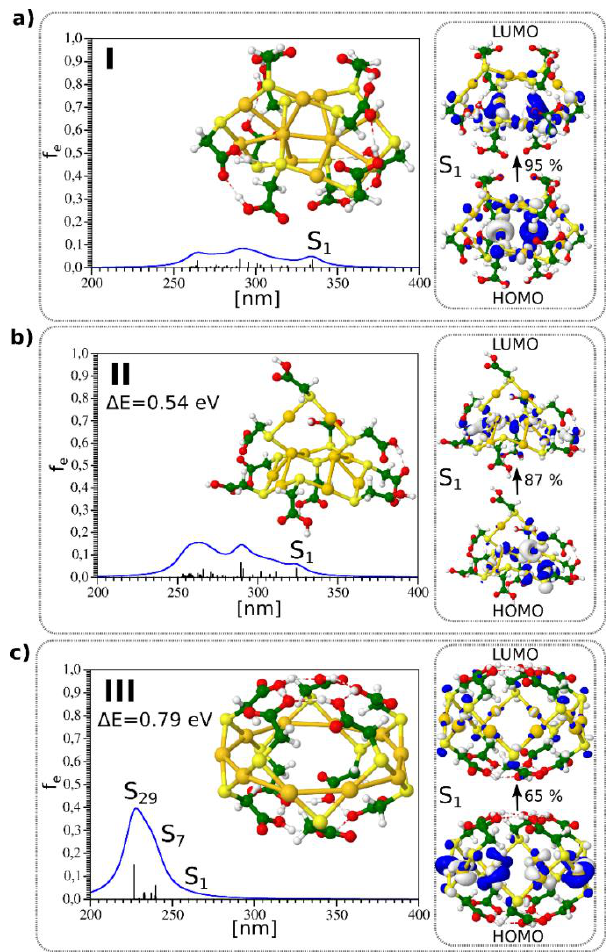
Figure 1. TD-DFT absorption spectrum and structure for three lowest energy isomers of Au 10 (TGA) 10 shown in ( a – c ) respectively. Leading excitations responsible for the characteristic features of absorption are illustrated on the right side. HOMO-LUMO for isomers I, II, and III are 4.54, 4.62, and 5.55 eV, respectively.